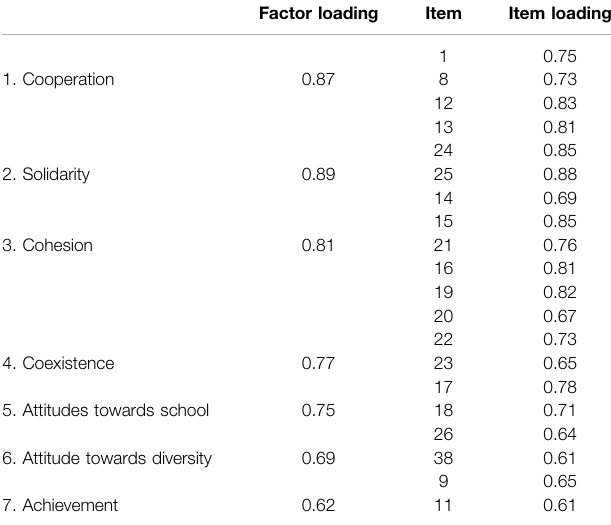
TABLE 3 | Factor and item loading for the con fi rmatory factor analysis.